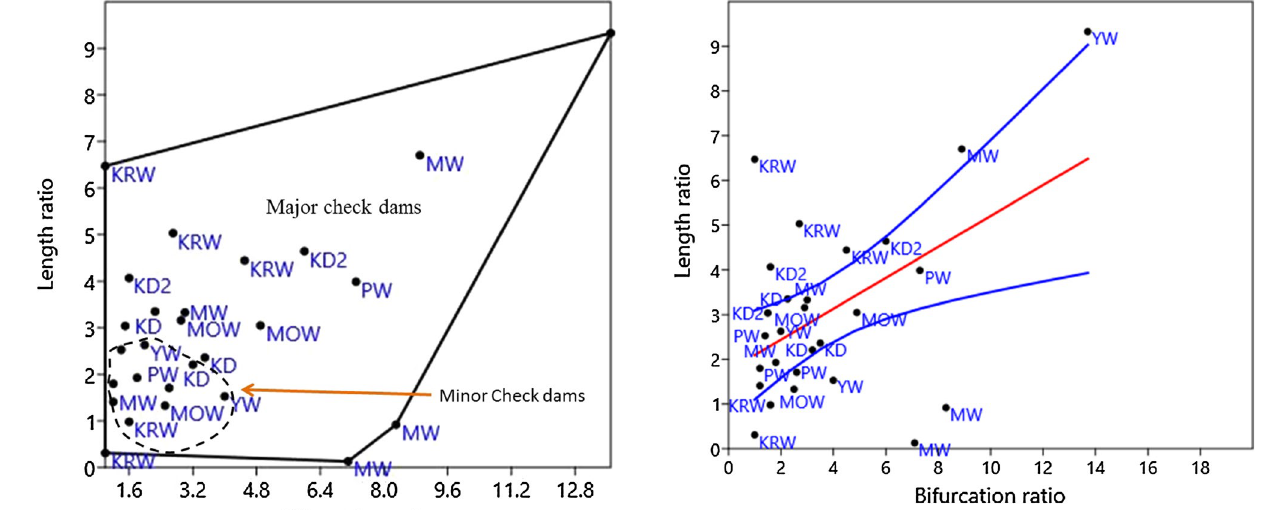
Fig. 4 Check dam suitability by Point plot with convex hulls